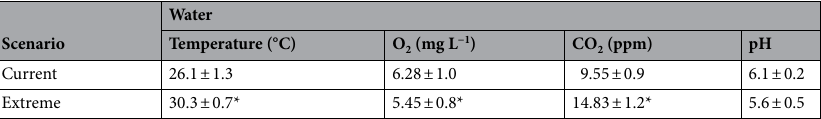
Table 1. Temperature, O 2 , CO 2 , and pH of the water in the aquariums in the experimental climate rooms. The two environmental rooms were computer-controlled in real-time to simulate current environmental conditions and the extreme climate scenario (RCP8.5, plus 4.5 °C and 900 ppm CO 2 ) as proposed by IPCC (2014) for the year 2100. *indicates significant difference from current scenario (Student’s t-test, p >